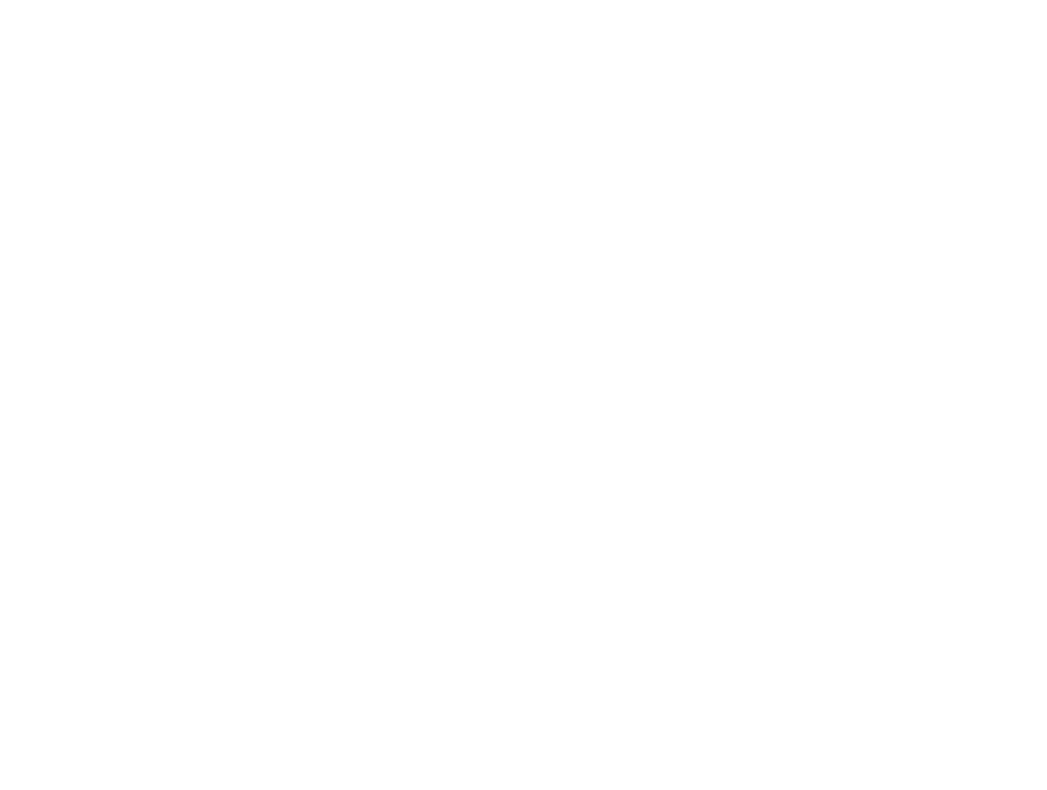
Frontiers in Plant Science | www.frontiersin.org